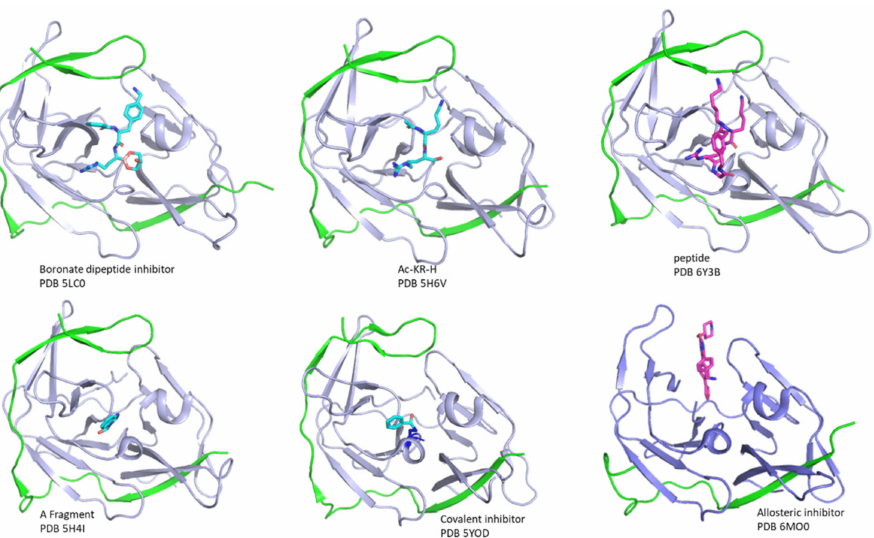
Figure 5. Structures of several protease-inhibitor complexes. The structures of inhibitors in complexes with proteases are shown. NS2B and NS3 are shown in green and light blue, respectively. The PDB accessing codes are indicated in the figure. All the structures are shown in the same orientation. Several types of inhibitors such as peptidic inhibitors, fragments, irreversible inhibitors, and allosteric inhibitors are shown in